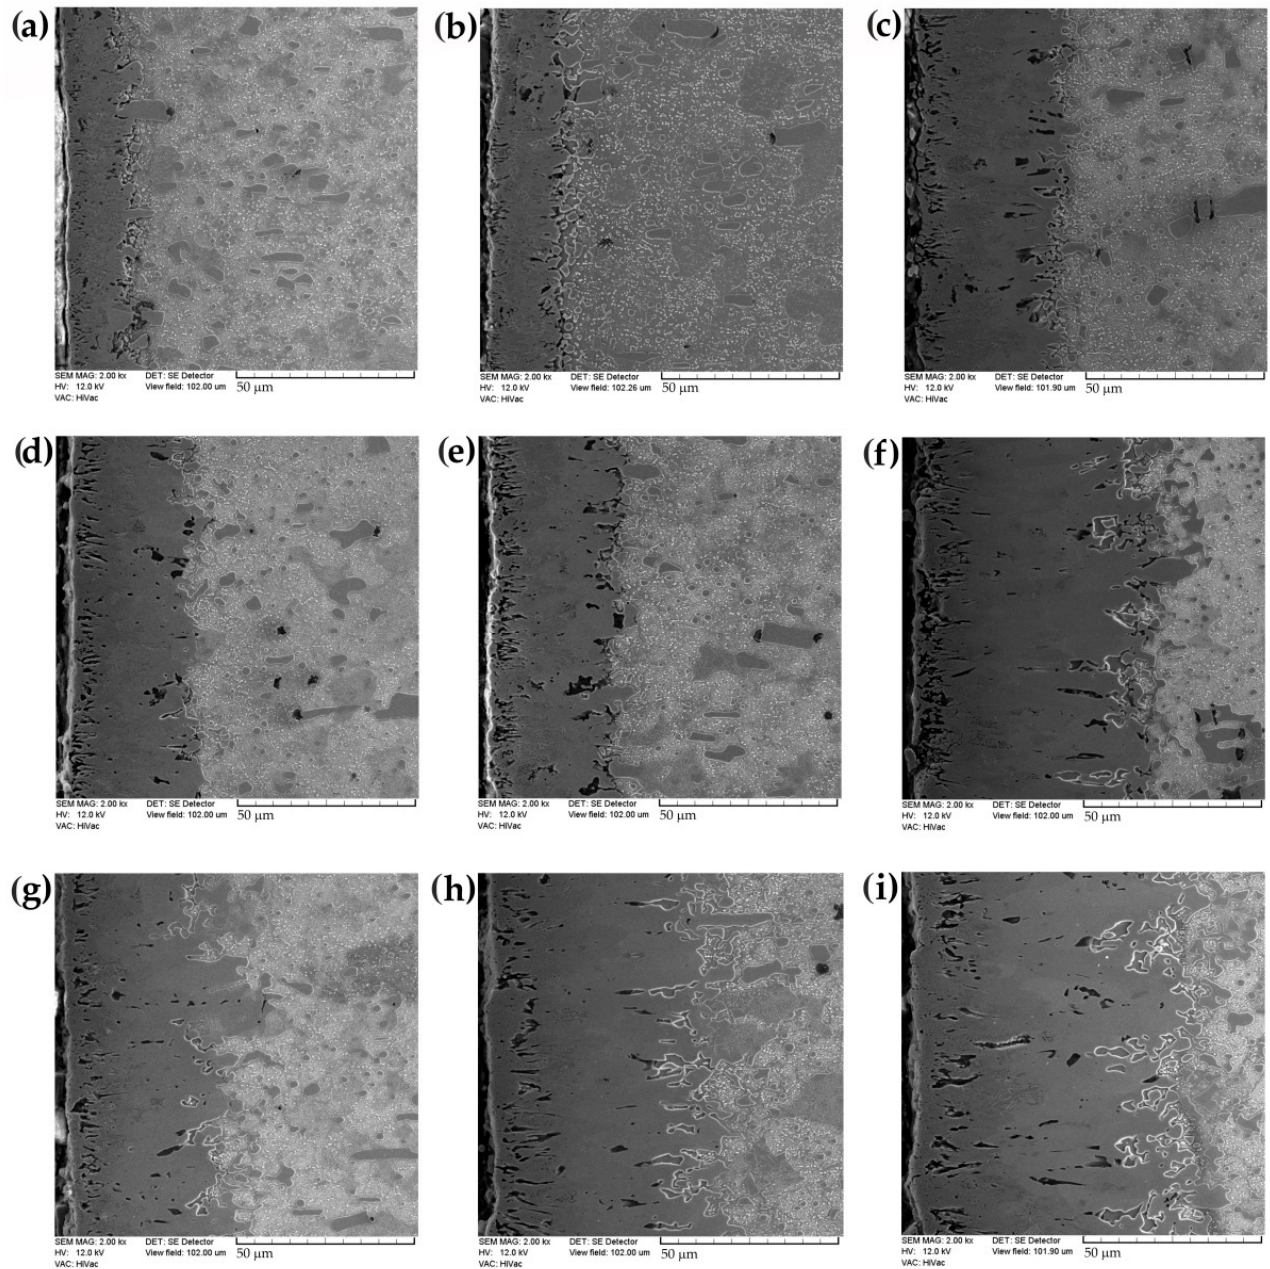
The OM images of the microstructure provided basic information about the zones identified in the borided X165CrV12 steel. They were used to measure the thickness of the outer FeB zone as well as the total layer thickness. Representative SEM images are shown in Figure 7. The layers, produced at 1123 K, were characterized by an average thickness from 12.45 to 38.53 µ m with increasing processing time from 3 h to 9 h (Figure 7a–c). A further increase in the boriding temperature resulted in the formation of a layer with a thickness ranging from 33.03 to 66.96 µ m, depending on the duration of the process (Figure 7d–f). The highest temperature of boriding (Figure 7g–i) ensured the highest thickness of layer, with 45.07, 59.62, and 78.76 µ m produced at processing times of 3, 6, and 9 h, respectively.